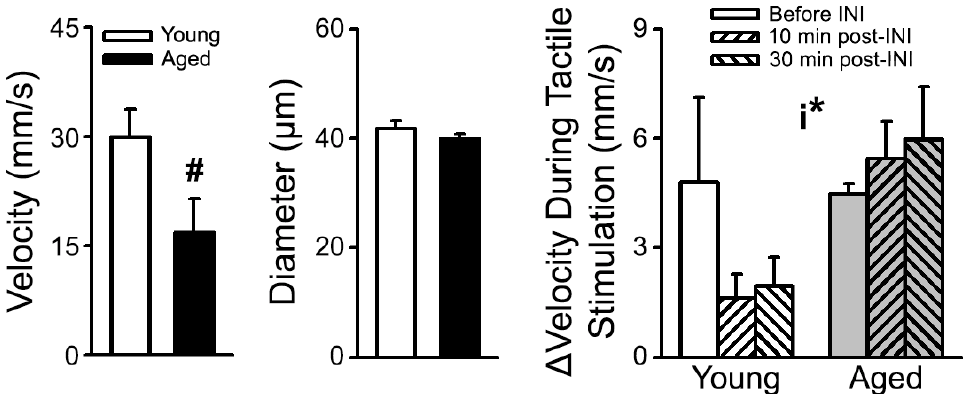
Figure 4. Measures of S1 CBF at rest and in response to tactile stimulation following INI delivery. ( Left ) Compared to young (n = 3) F344 animals, aged (n = 3) animals showed a trend (#) for reduced absolute red blood cell velocity in S1 (Student’s t -Test; p = 0.09). ( Middle ) No change in vessel diameter was detected (Student’s t -Test; p > 0.05). ( Right ) Measures of Δ velocity during tactile activation was measured across age and in response to INI administration. A significant interaction (i*) was noted, with young animals responding to INI with reduced Δ velocity while aged animals responded with an increase (2-way RM ANOVA; F (2,17) = 4.43; p = 0.05) [173].